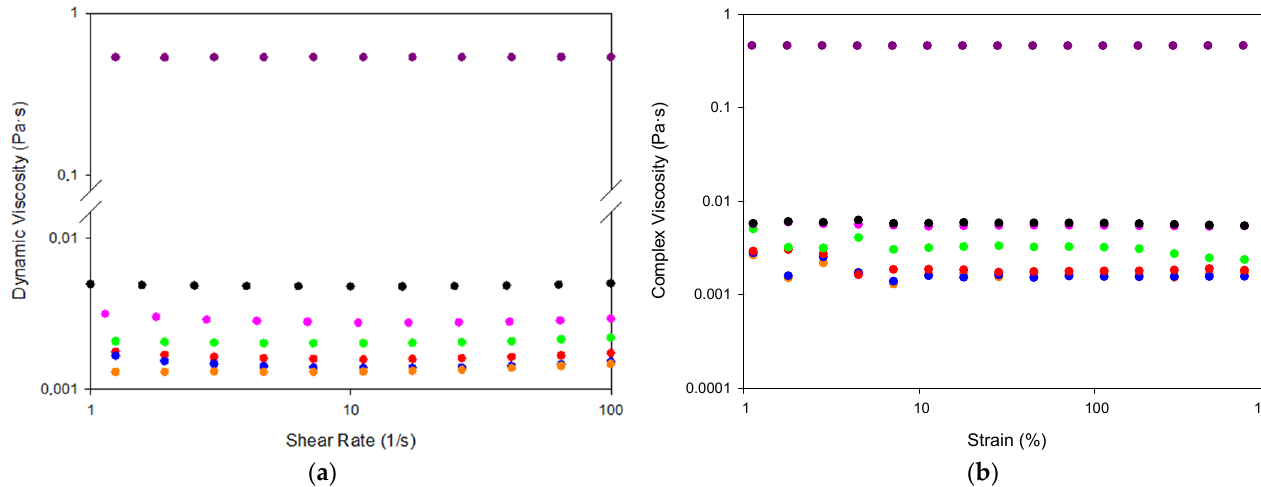
Figure 4. ( a ) Shear rate–shear viscosity flow curves and; ( b ) strain amplitude sweeps at a fre- quency of 0.05 Hz obtained for water, IL and IL/Water emulsions at 10 °C (  ) Water, (  ) 1IL/Wa- ter, (  ) 5IL/Water, (  ) 10IL/Water, (  ) 15IL/Water, (  ) 25IL/Water and (  ) IL.